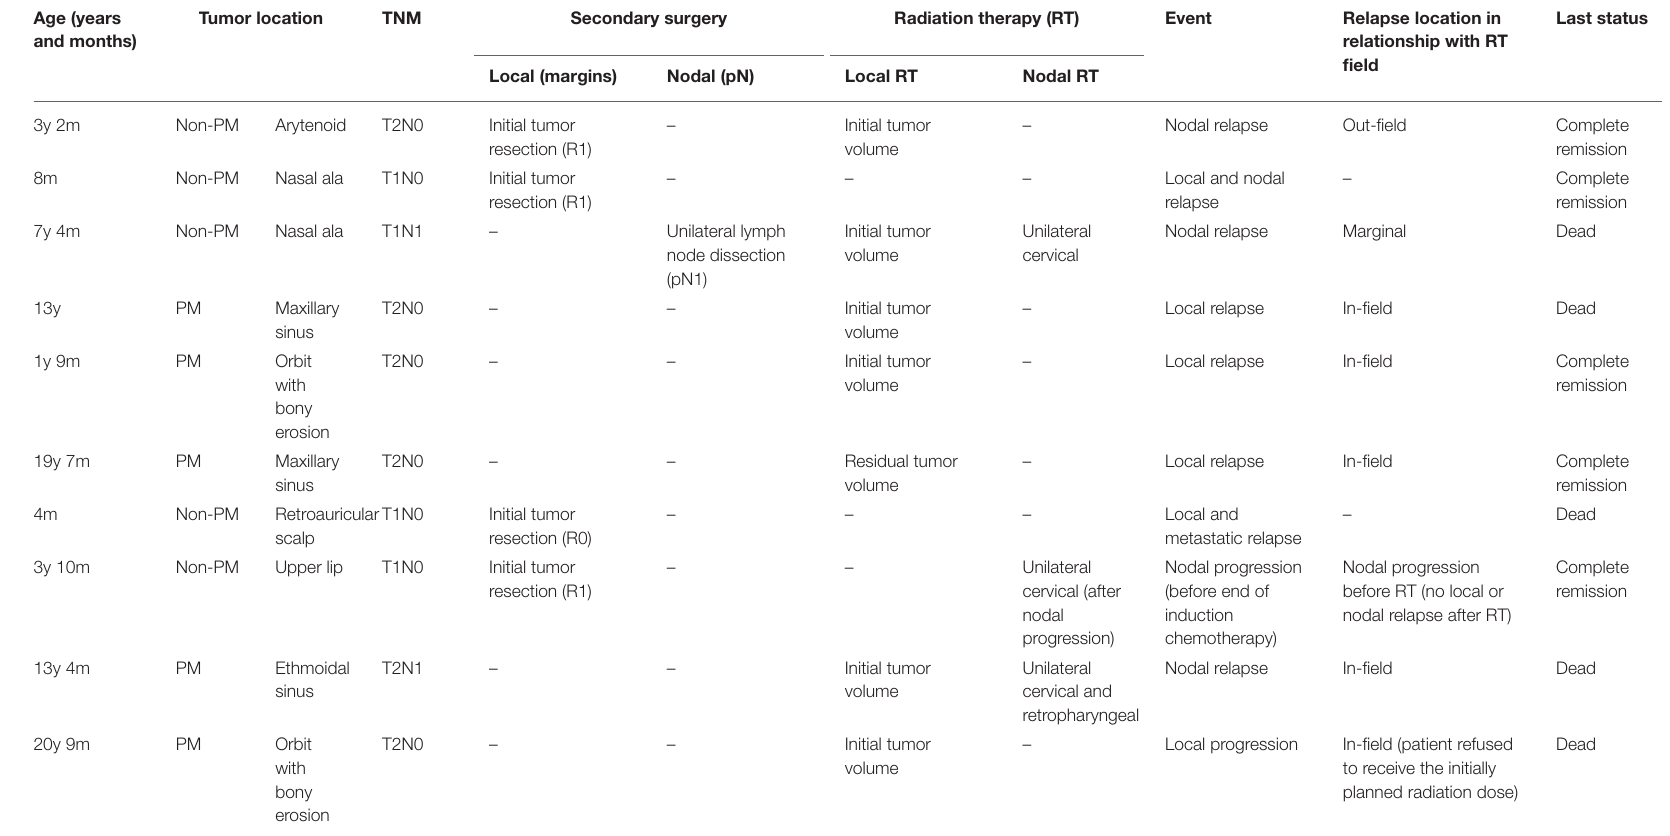
PM, parameningeal; RT, radiation